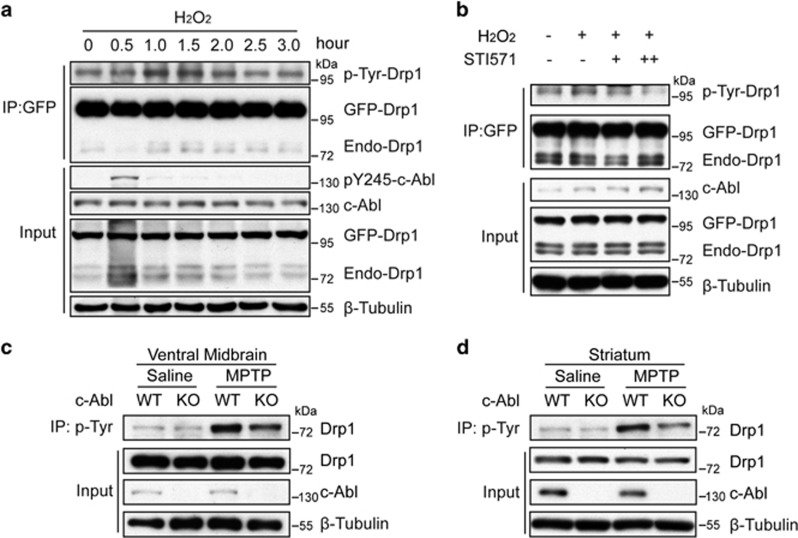
c-Abl activation promotes tyrosine phosphorylation of endogenous Drp1. (a) Lysates of SH-SY5Y cells with 1 mM H2O2 treatment for the indicated times were immunoprecipitated with GFP antibody and subjected to immunoblot with the indicated antibodies. (b) Lysates of SH-SY5Y cells with 1 mM H2O2 treatment for 1 h, along with or without STI571 treatment, were immunoprecipitated with GFP antibody and subjected to immunoblot with the indicated antibodies. (c and d) Mice were treated in the same way as in Figure 1a. Ventral midbrain (c) and striatal tissues (d) were collected and subjected to immunoprecipitation using an anti-phospho-tyrosine antibody followed by immunoblotting with the indicated antibodies